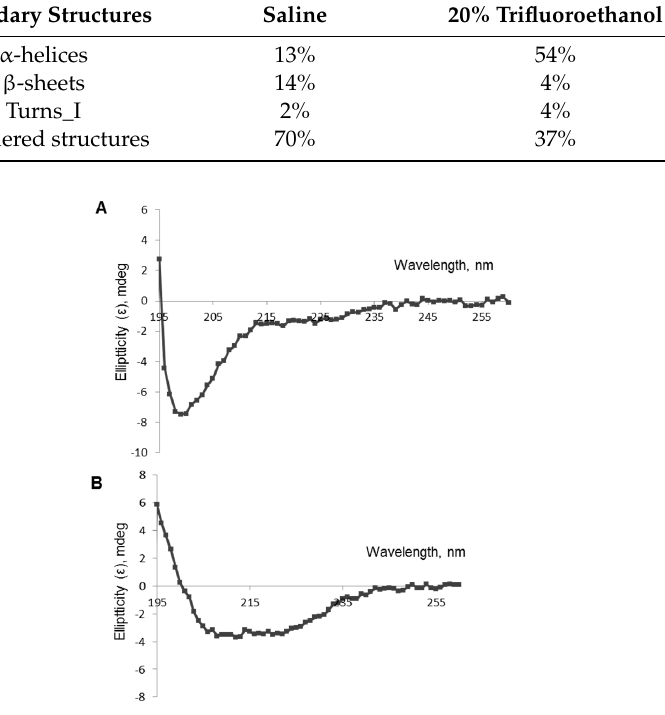
Figure 4. CD spectra of TBI_tag protein: ( A ) saline; ( B ) 20% trifluoroethanol in saline.